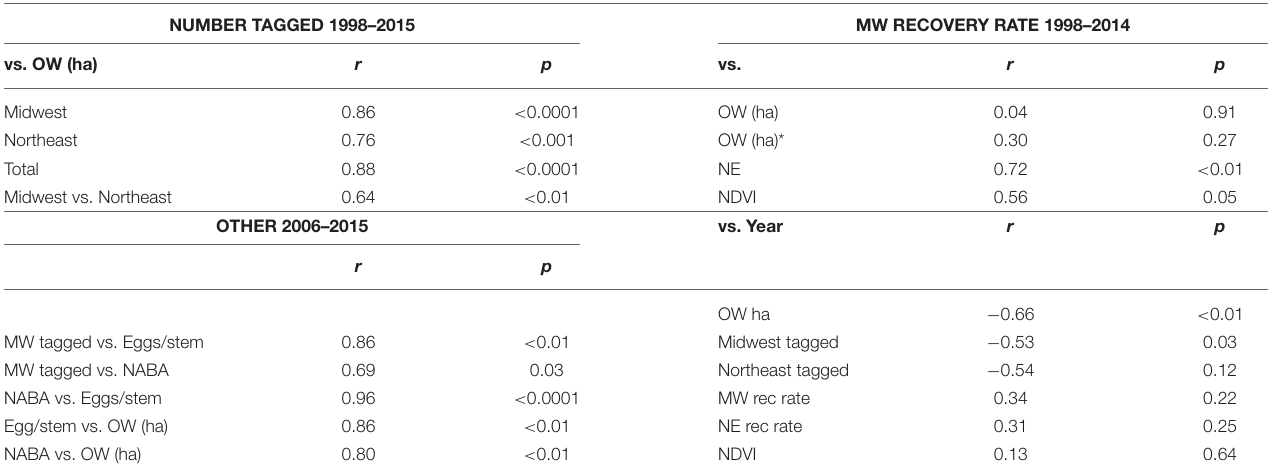
TABLE 2 | Summary of correlations and probabilities.